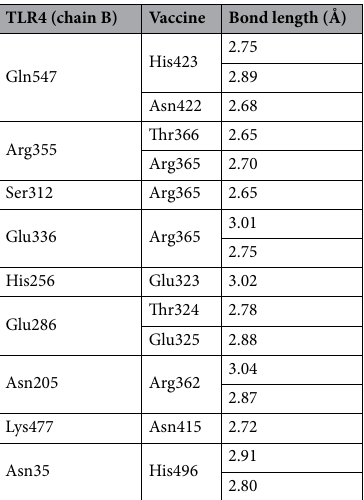
Table 5. List of residues in the docked complex that are involved in hydrogen bonds between the vaccine and TLR4 (chain B).